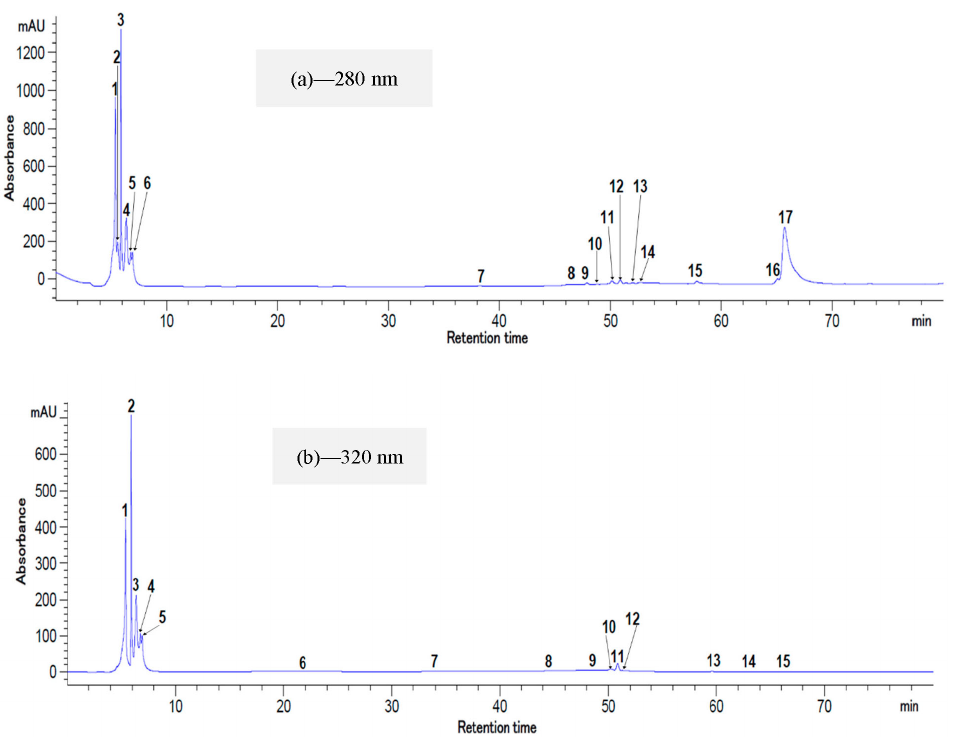
Figure 6. HPLC chromatogram for the flavonoids and polyphenols from Ziziphus mauritiana extract